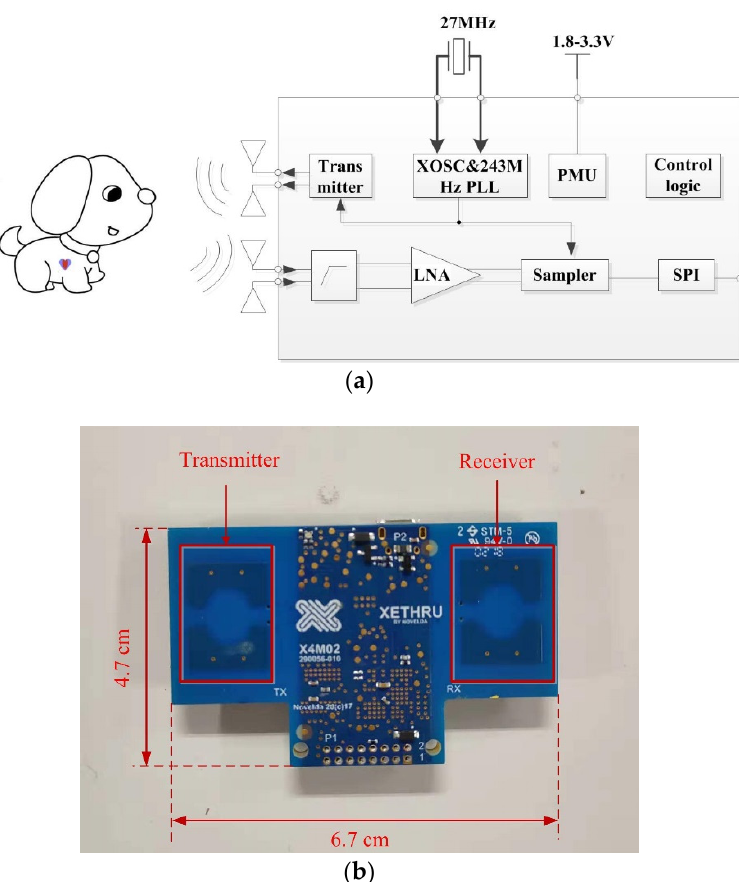
Figure 2. ( a ) Block diagram of the radar sensor SoC (system on chip); ( b ) the image of a real radar sensor.